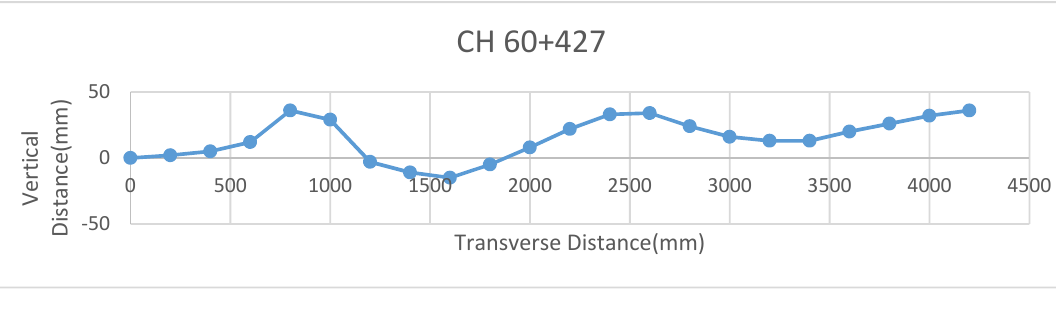
Figure 11. Profile of trench measurements of 60 + 365 km.